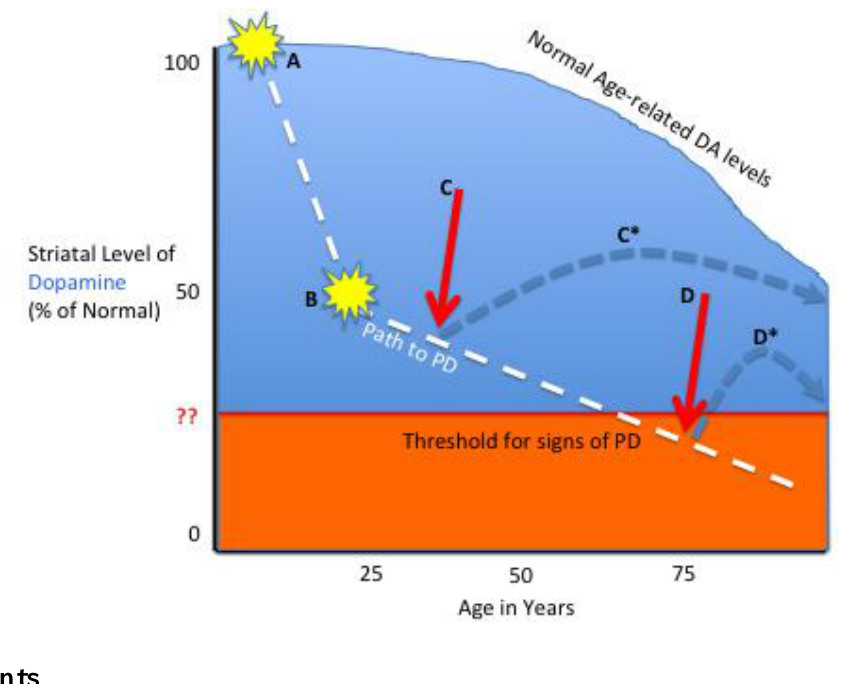
Figure 3. Schematic of Future Gene Therapy Options in PD. Normal aging is associated with gradual reduction in striatal DA, associated with reduced numbers of SNc dopaminergic neurons. Despite this age-related DA reduction, most individuals do not achieve a threshold level of dopamine depletion during life, and do not develop PD. In PD patients, however, hereditary (A) and/or environmental (B) factors/events lead to a more drastic DA depletion (Path to PD) that crosses the PD threshold and results in clinical signs. The slopes from A to B and in the Path to PD are variable. In cases of early PD, preferably before clinical signs are evident, GFL gene therapy (C) may protect from further nigrostriatal neuronal loss and restore near-normal DA levels (C*) for the patient’s life. In patients with symptomatic PD, use of AADC or AADC+ gene therapy (D), has the potential to increase striatal levels of dopamine above the threshold (D*) and restore more normal motor